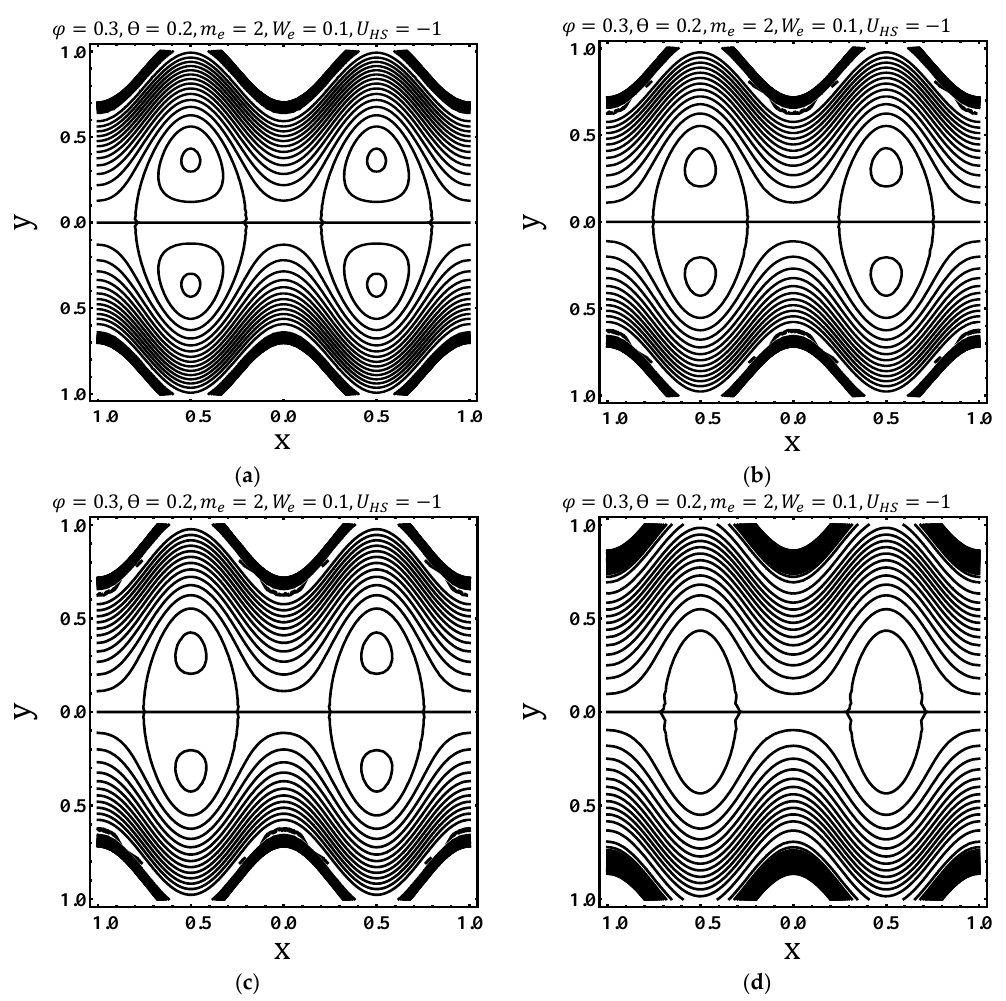
Figure 6. Streamline distribution for ( 𝐚 ) . 𝑛 𝑖 = 0.389 ( 𝐛 ) .𝑛 𝑖 = 0.589 ( 𝐜 ) .𝑛 𝑖 = 0.789 ( 𝐝 ) .𝑛 𝑖 = 1.0.